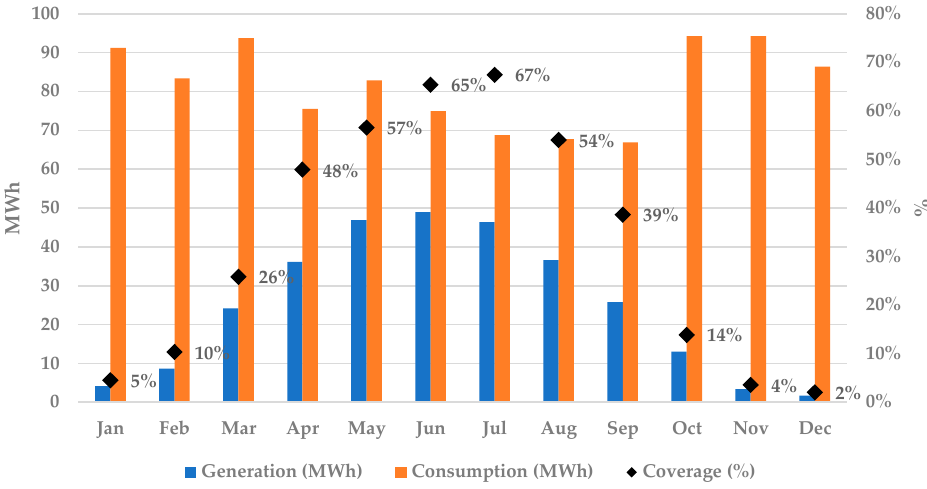
Figure 8. Monthly comparison between electricity generated by PV modules and actual electricity consumption.